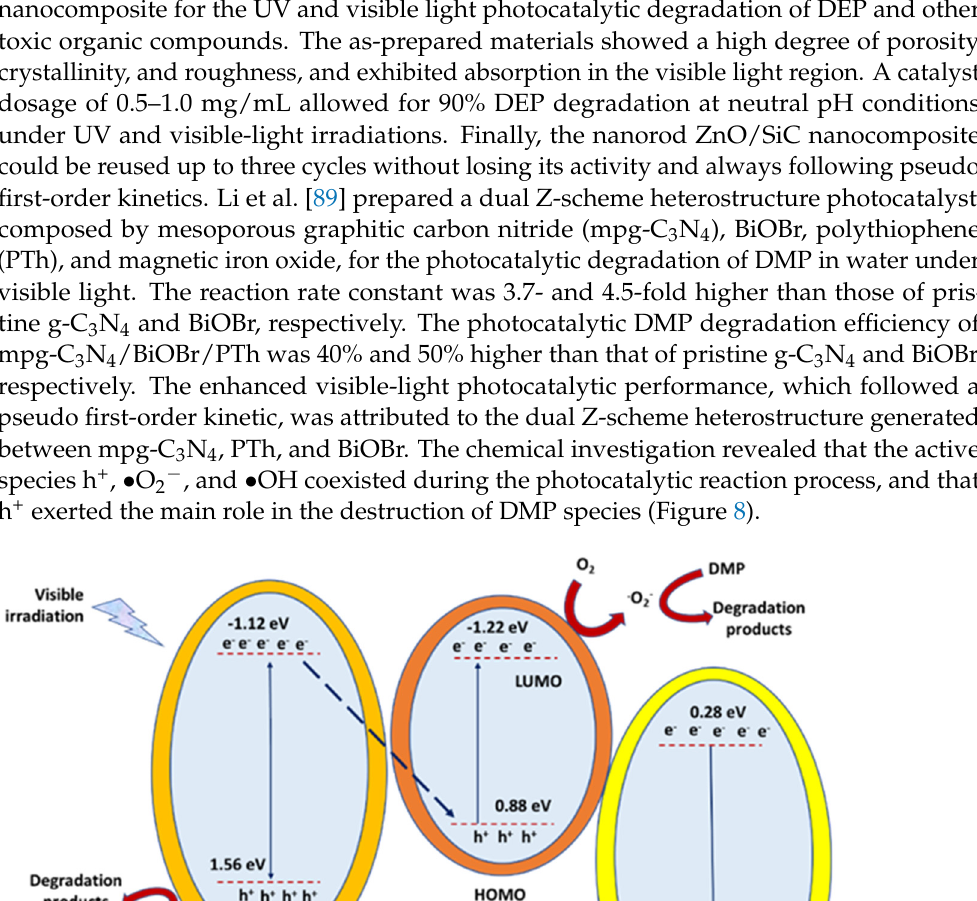
Ce 4+ /Ce 3+ redox couples exerted a synergistic catalytic effect in addition to electron transfer